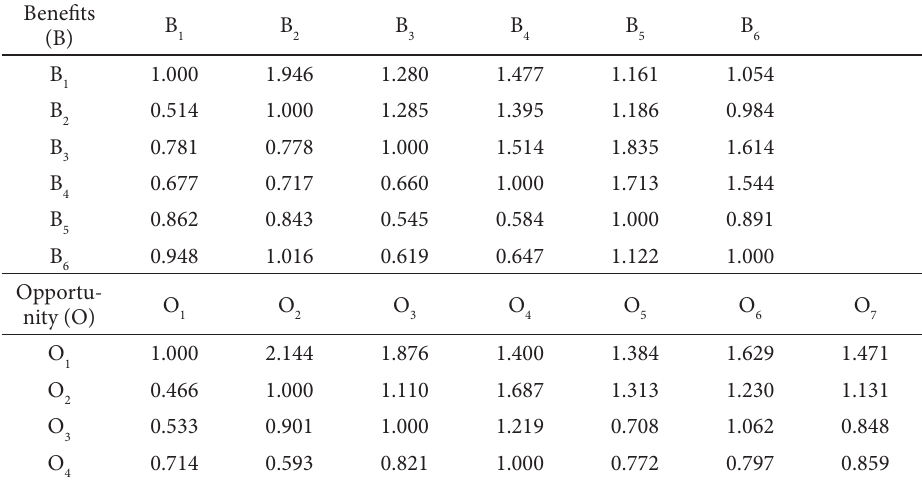
Table A3. Criteria for aggregate pairwise comparison matrix for sub-criteria of level